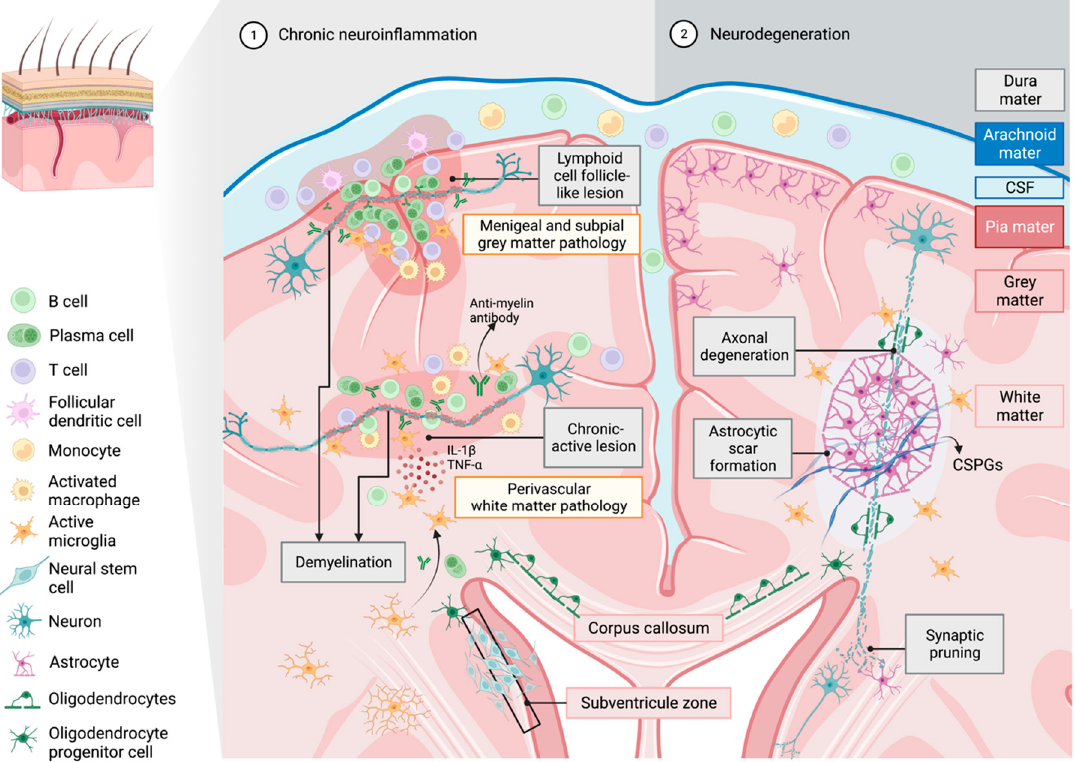
Figure 2. Microglia during chronic neuroinflammatory and neurodegenerative conditions. B cells with other lymphocytes and myeloid cells residing in the cerebrospinal fluid (CSF) infiltrate the subpial and meningeal cerebral cortex and the region of perivascular spaces, forming ectopic B cell follicle-like lesions as observed in progressive multiple sclerosis. As these cells percolate through the cortices towards the axon, resulting in chronic inflammation in grey and white matter, microglia that are activated by bound myelin-specific immunoglobulins secrete proinflammatory cytokines, contributing to promulgated myelin and axonal damage. Under neurodegenerative conditions, the disrupted myelin sheath can act as one of the main precursors for further axonal damage, followed by the formation of reactive astrocytic scarring potentiated through the interaction with activated microglia. [Illustration created in BioRender.com accessed on 17 October 2022].